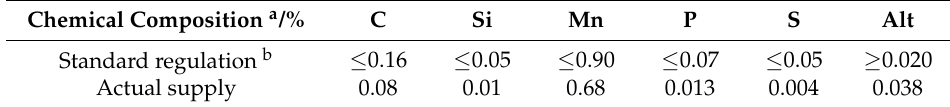
Table 1. Chemical Constituents of hot rolled and high-strength pickling enamel steel BTC330R. Chemical Composition a /% C